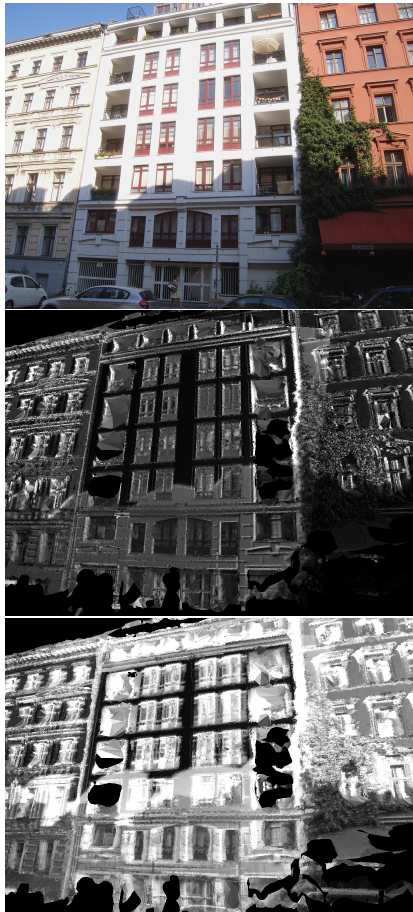
Figure 5. From top to bottom: fac¸ade image, visualization of colour differences to neighbouring images only, and visualiza- tion of colour differences to complete sequence. The fac¸ade in the center of the image reflects with a very bright intensity. If compared to the neighbouring images only, the differences are very small. Consequently, the wall diffusely reflects the light. If the colour differences are calculated over the complete sequence, the borders between wall and windows do not stay so clear. This might be caused by a specular fraction of the reflection or by incorrect reconstructed object surfaces in the mesh close to the window